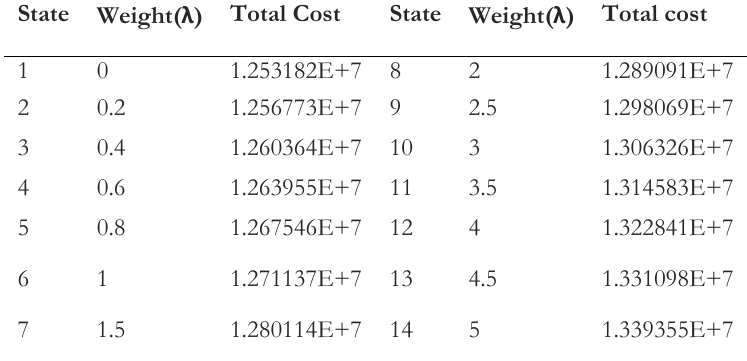
Table 9. Objective function changes based on the changes in robust weight.